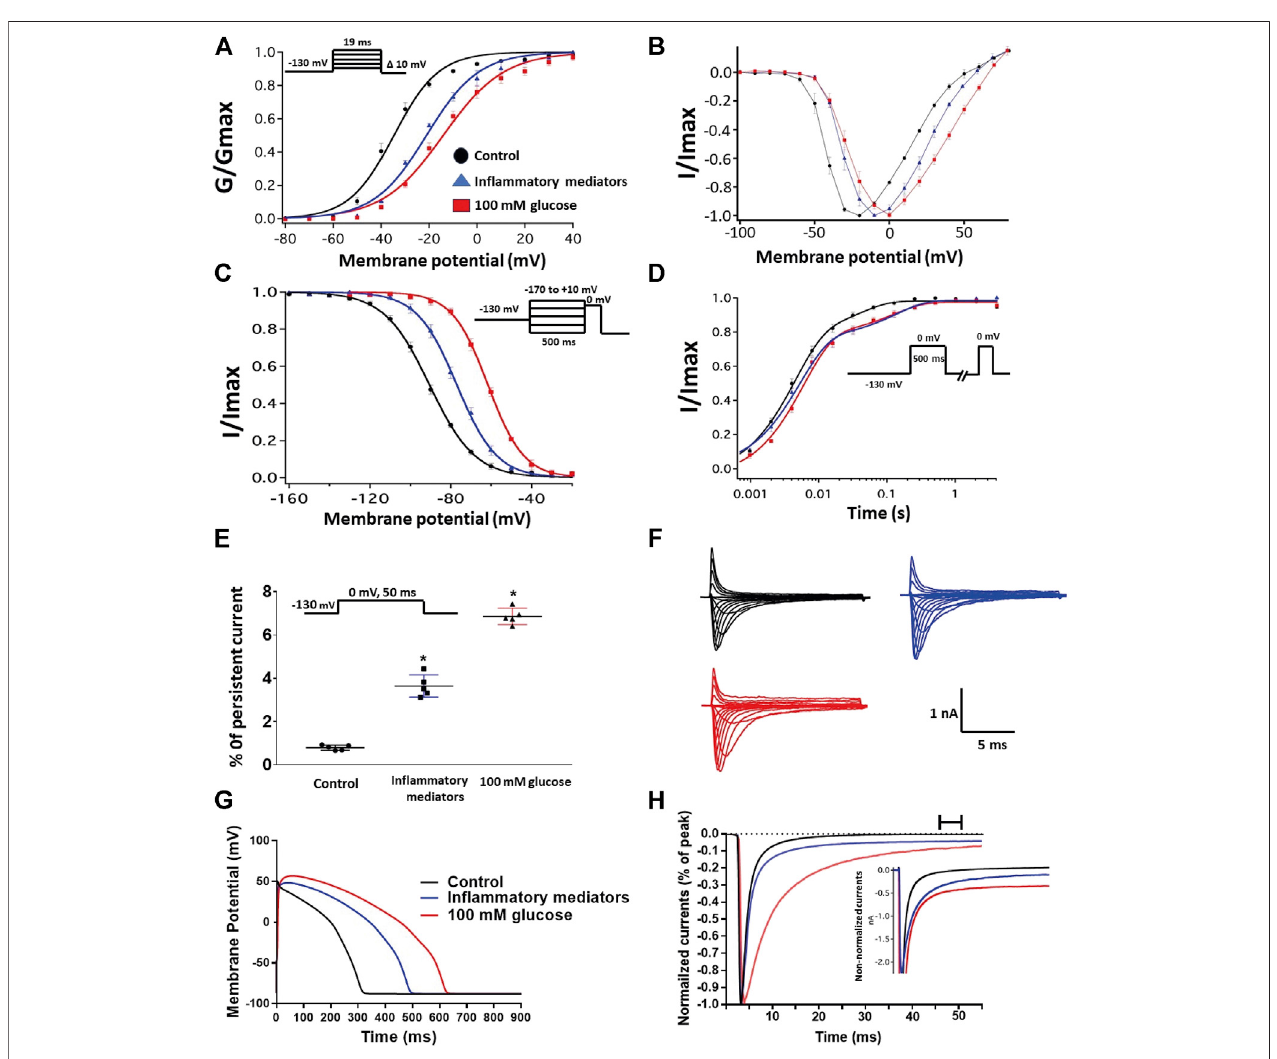
FIGURE 1 | (A) Effect of a cocktail of in fl ammatory mediators or 100 mM glucose or their vehicle (for 24 h) on conductance curve of Nav1.5 transfected CHO cells with the insert showing the protocol ( n (cid:2) 5, each). (B) IV curves (C) Effect of a cocktail of in fl ammatory mediators or 100 mM glucose or their vehicle (for 24 h) on SSFI of Nav1.5transfectedCHO cells withthe insertshowingthe protocol ( n (cid:2) 5,each). (D) Effect ofacocktailofin fl ammatorymediators or 100 mM glucose ortheir vehicle (for 24 h) on recovery from fast inactivation of Nav1.5 transfected CHO cells with the insert showing the protocol ( n (cid:2) 5, each). (E) Effect of a cocktail of in fl ammatory mediators or 100 mM glucose or their vehicle (for 24 h) on the percentage of persistent sodium currents of Nav1.5 transfected CHO cells with the insert showing the protocol ( n (cid:2) 5, each). (F) Representative families of macroscopic currents. (G) In silico action potential duration of Nav1.5 transfected CHO cells incubated in in fl ammatory mediators or 100 mM glucose or the vehicle for 24 h. (H) Representative persistent currents across conditions. Currents were normalized to peak current amplitude. Bar above current tracesindicates period during which persistentcurrent was measured. Insetshows non-normalized currents. * p < 0.05 vs.